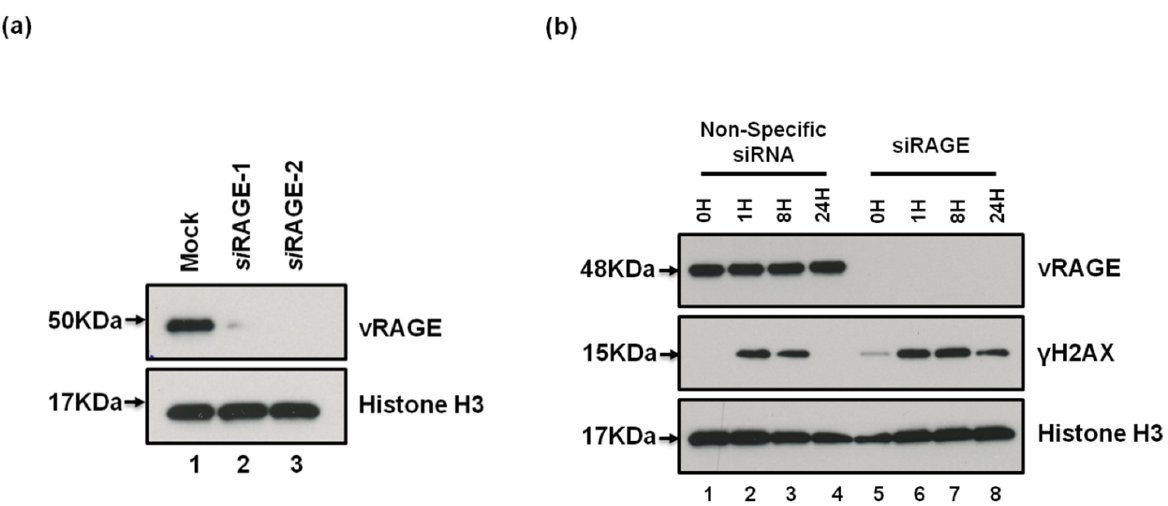
Figure 5. Importance of vRAGE in timely DNA damage response of SCLC cells. ( a ) Representative immunoblots showing the siRAGE (siRAGE1 and siRAGE2) mediated depletion of vRAGE from SHP-77 cells after 72 h of transfection. The mock transfection served as an internal control. ( b ) Representative immunoblots from the lysates of control or RAGE depleted SHP-77 cells (siRAGE-2), treated with etoposide (2.5 µM for 1 h) and probed for the DNA damage marker γH2AX at indicated post-damage intervals. The expression/depletion of vRAGE was confirmed by using a vRAGE specific antibody generated during this study. Histone H3 used as a loading control. The images of uncropped western blots are shown in Figure S8.